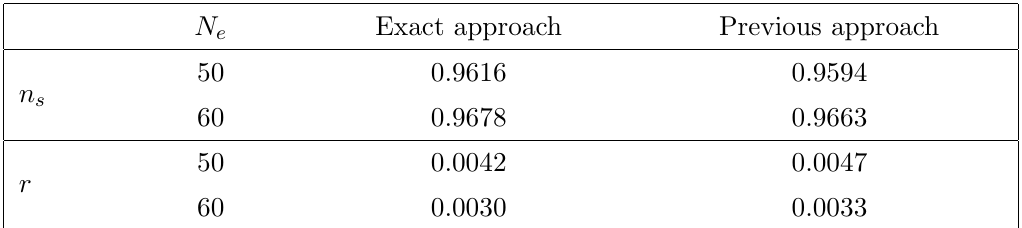
Table 3 . Values of the scalar spectral index n and tensor-to-scalar ratio r for the Higgs in(cid:13)ation S model in our accurate approach in comparison with the previous approximate approach